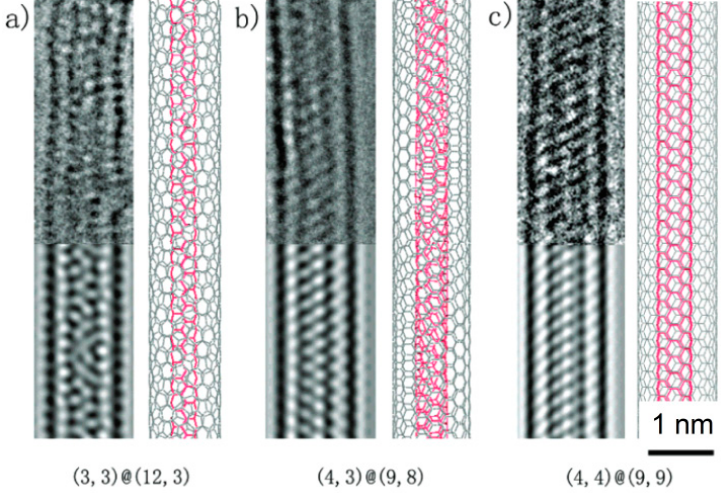
Figure 37. Set of HRTEM image (top left), simulation (bottom left), and schematic model (right) for ( a ) (3,3)@(12,3) DWCNTs, ( b ) (4,3)@(9,8) DWCNTs, and ( c ) (4,4)@(9,9) DWCNTs. Scale bar, 1 nm. Reproduced with permission from Guan et al. [125]. Copyright American Chemical Society, 2008.